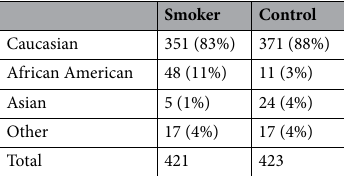
Table 3. The ethnicity of smoking and non-smoking subjects.